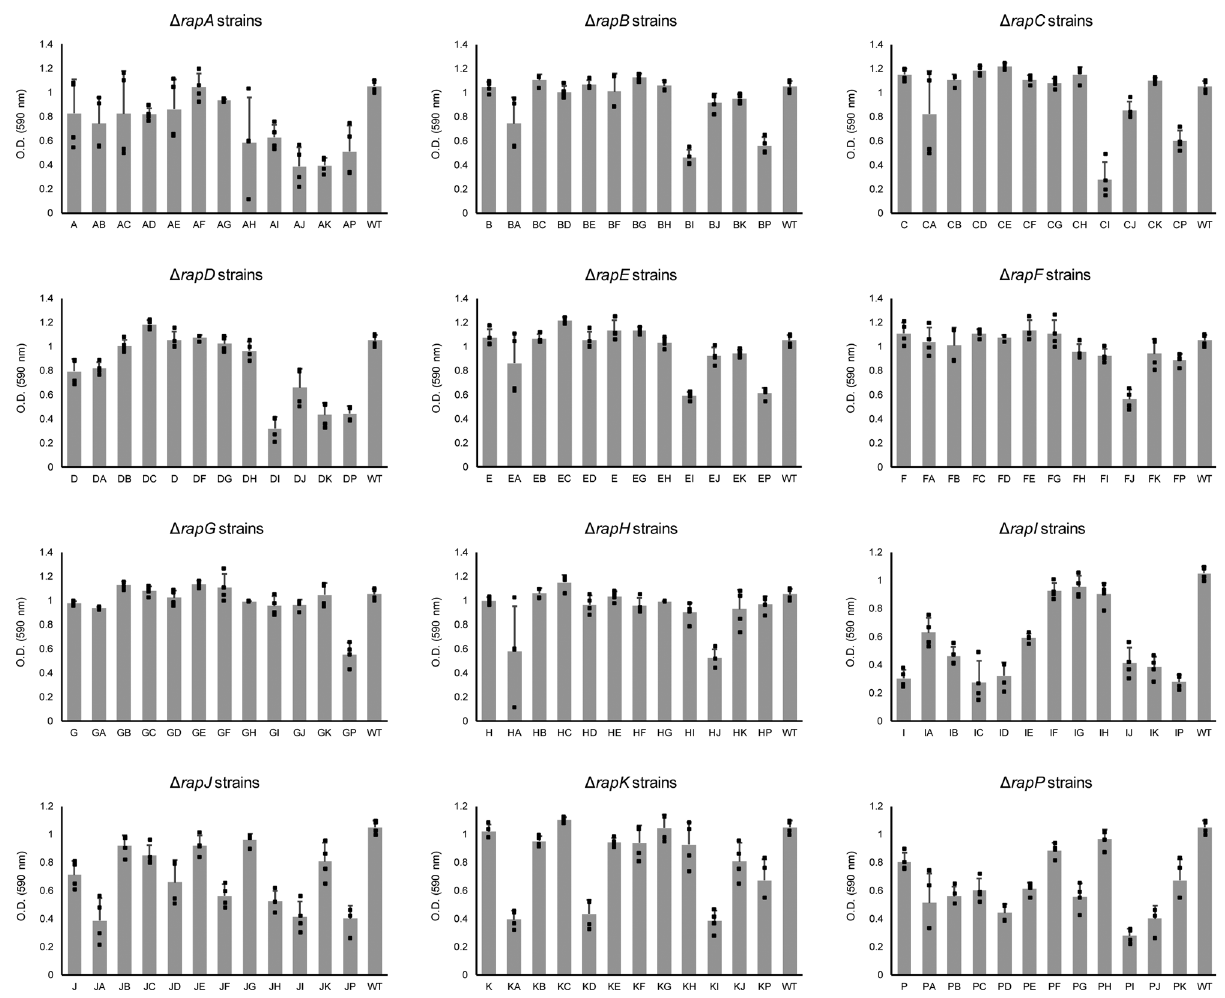
Fig. 4 Growth of B. subtilis DK1042 and rap – phr mutants (as OD 590 increment after 16 h). X -axis indicates which rap – phr genes have been deleted (A indicates a Δ rapA mutant, AB indicates a Δ rapA – Δ rapB mutant, and so on), WT indicates B. subtilis DK1042. Bars represent the average of four independent replicates. Error bars represent standard